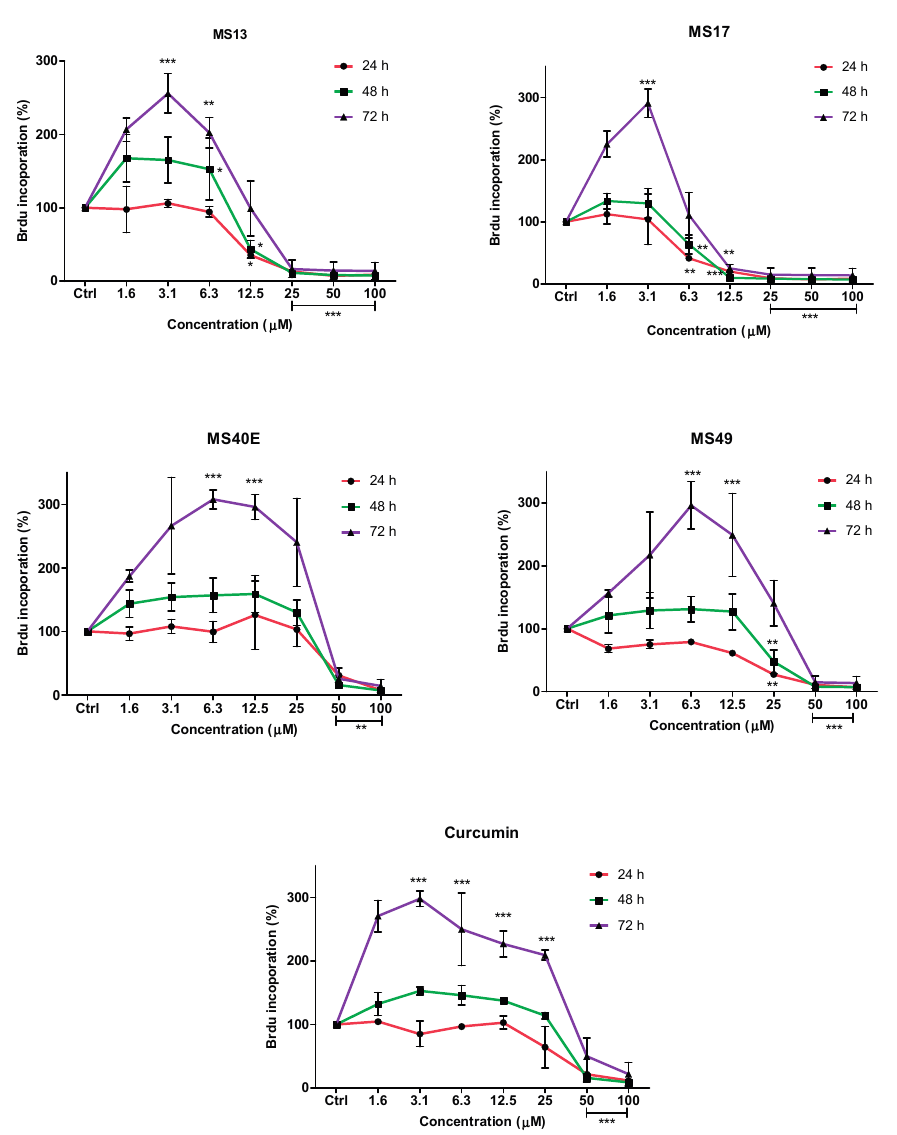
Figure 5. Anti-proliferative effect of MS13, MS17, MS40E, MS49 and curcumin on DU 145 cells at 24, 48 and 72 h. Results are expressed as means ± S.E. from three independent experiments. Percentage BrdU incorporation and comparison between data sets performed using ANOVA. * p < 0.05, ** p < 0.01 and *** p < 0.001 indicates statistically significant differences between the means of values obtained with treated vs. untreated cells